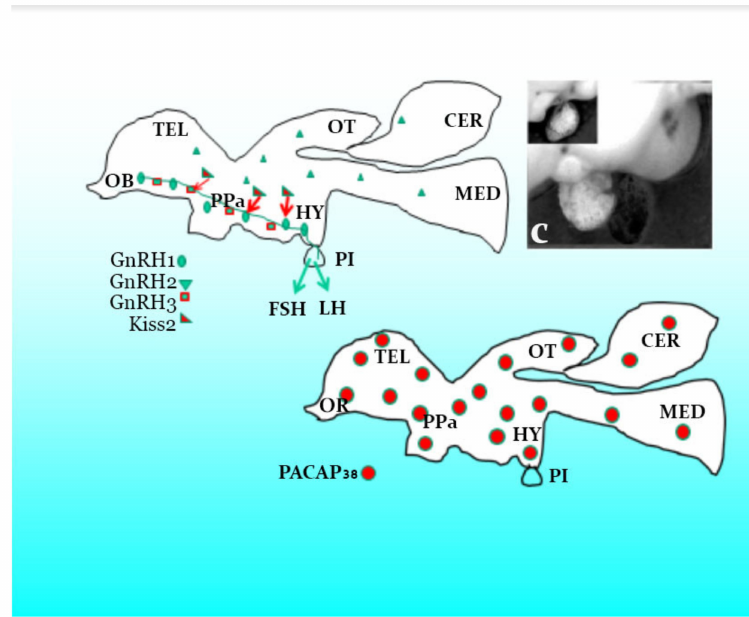
Figure 4. Proposed sketch of hormones secretion from the brain and pituitary of female blue gourami s based on gene expression in various studies [10,17,18,20,30,31,34,36,55]. OB—Olfactory bulb, OT—Optic